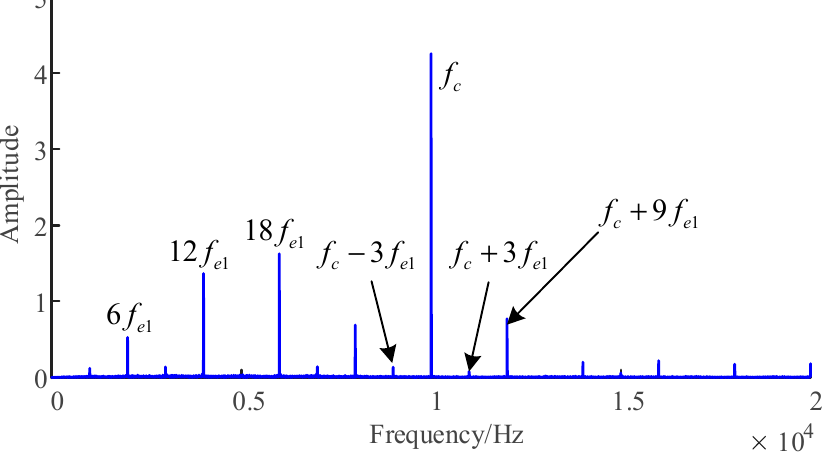
Figure 5. Electromagnetic torque frequency domain.